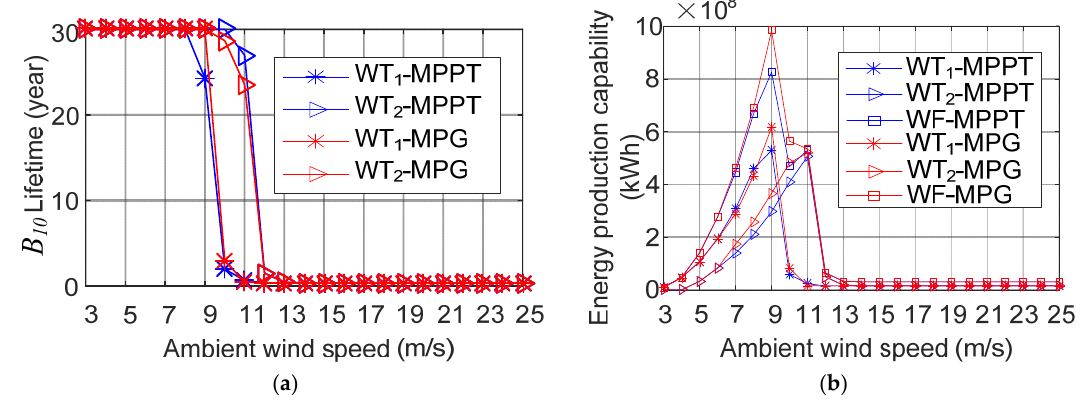
Figure 11. Comparison of: ( a ) B 10 Lifetime of power converter; ( b ) energy production of each turbine between the MPPT method and the MPG method at the wind direction of 270°.